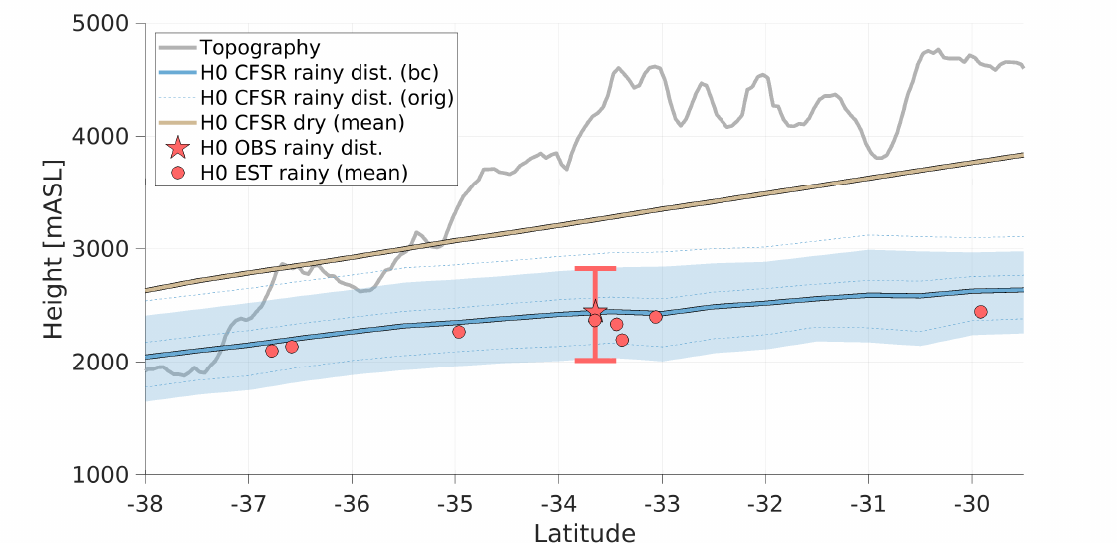
Figure 4. Latitudinal variation of the mean H 0 along the coast of Central Chile during days with (blue line) and without (brown line) precipitation, based on CFSR data. Blue shading indicates the interquartile range of H 0 during wet days. Gray line indicates the 97.5th percentile of terrain elevation, signaling the Andes crest level. Red dots are mean H 0 estimations based on surface data at selected National Weather Service (DMC) stations and the red whiskers indicate the interquartile range of H 0 using the observed values from the Santo Domingo